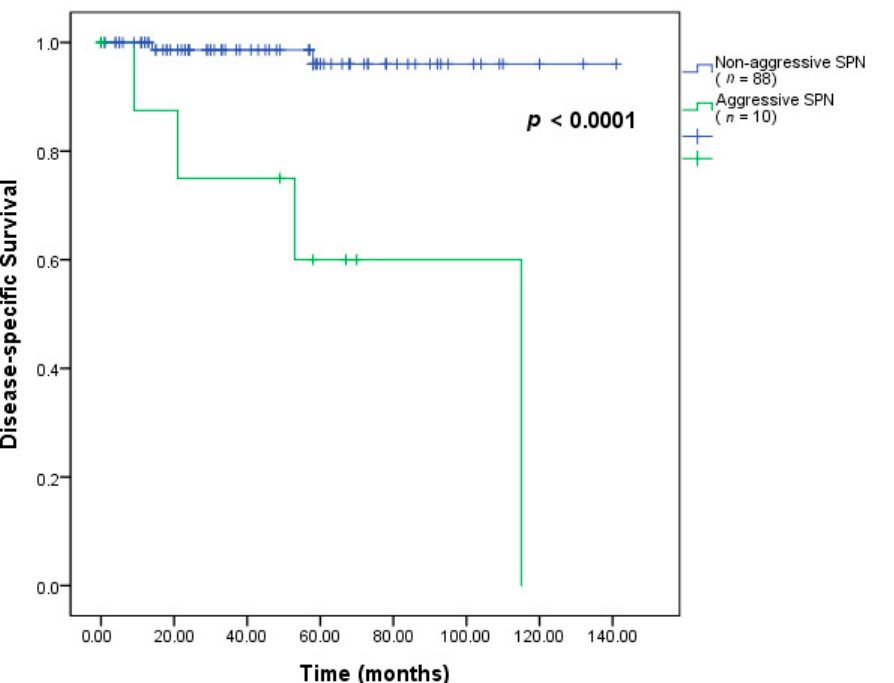
Figure 1. Disease-specific survival plot for aggressive versus non-aggressive SPN; SPN, solid pseudopapillary neoplasm.